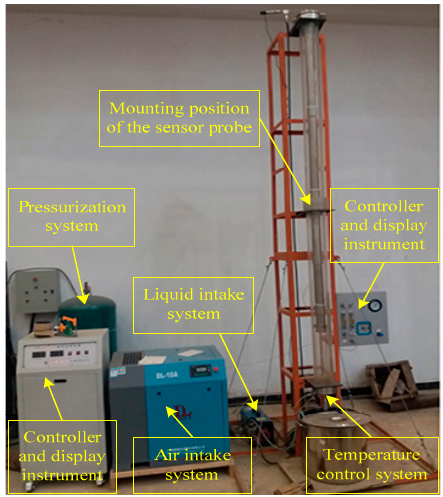
Figure 10. The two-phase flow simulator.